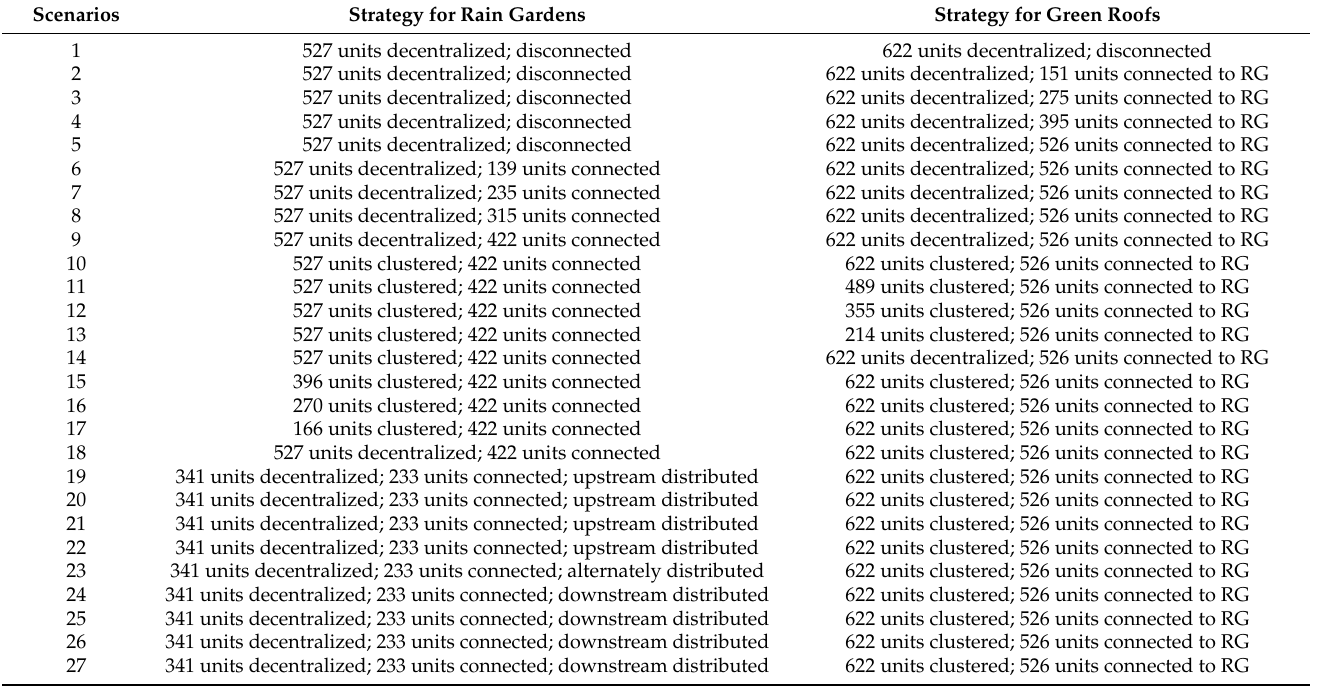
Table 1. Summary of the distribution strategies in scenarios 1 to